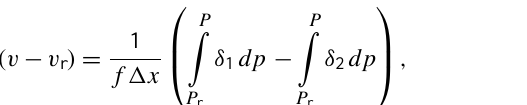
deepest common pressure